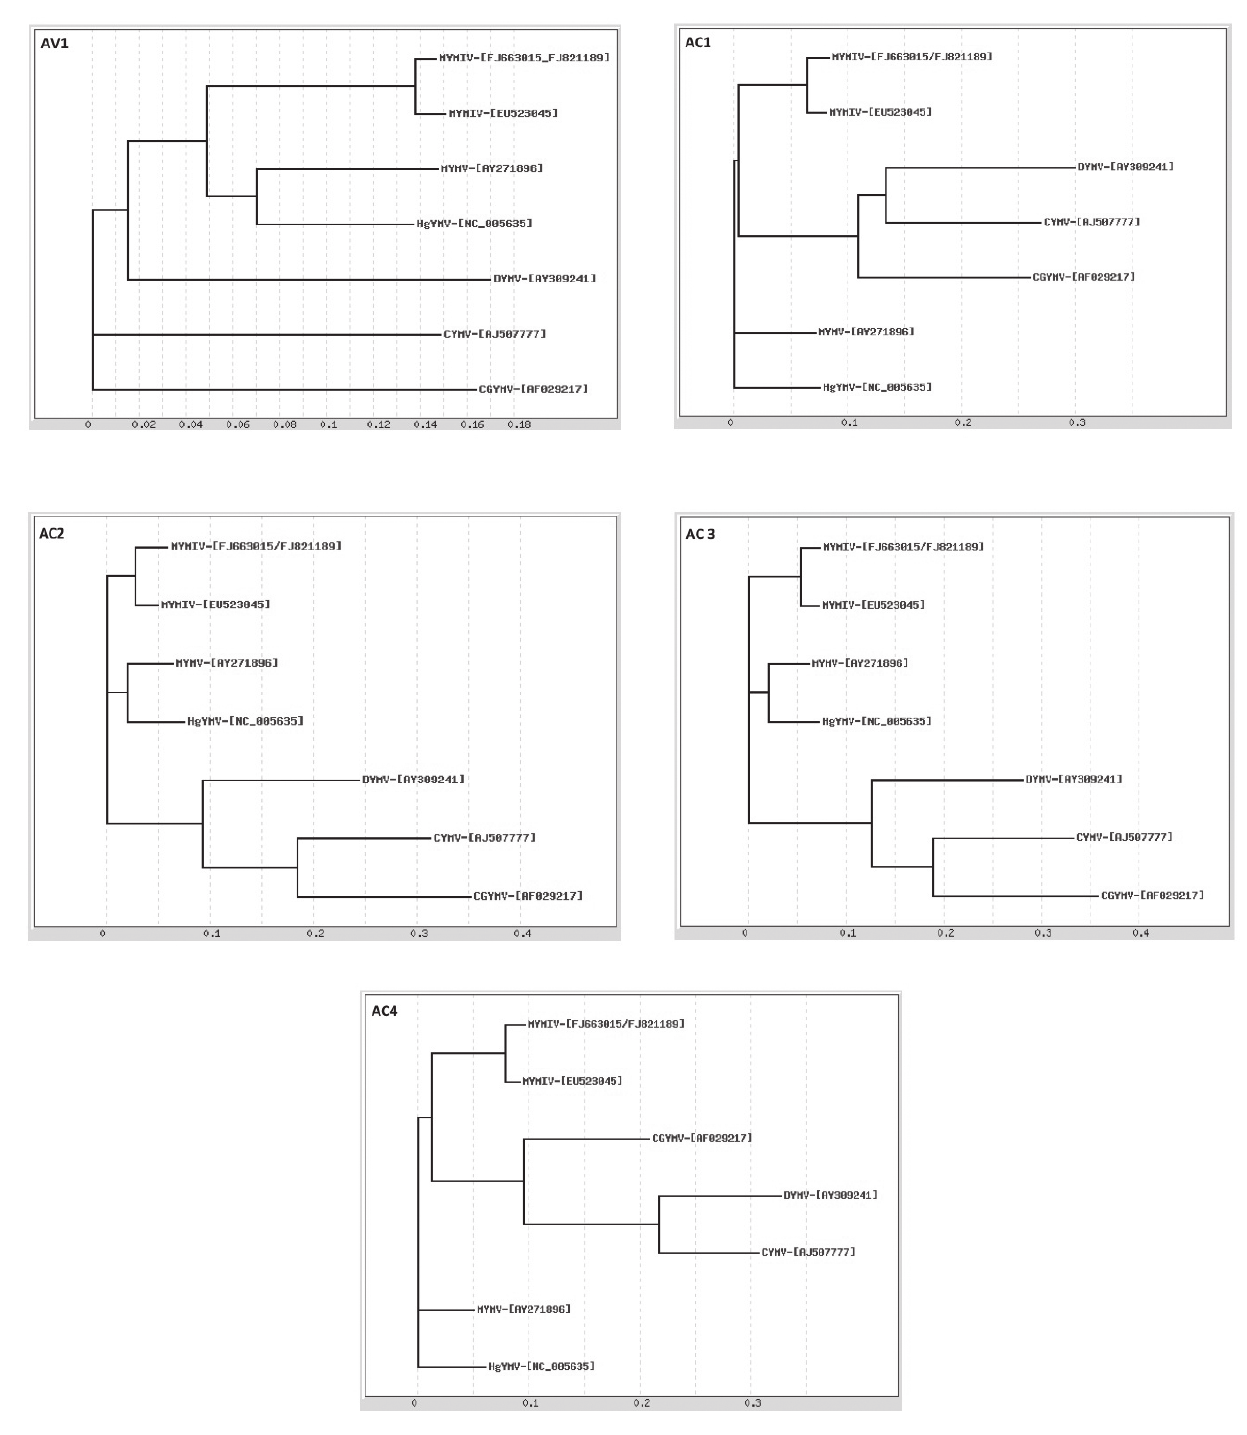
Figure 2. Cluster phylogram illustrating the phylogenetic relationship based on the multiple alignments of nucleotide sequences of genes AV1, AC1, AC2, AC3 and AC4 of the MYMIV isolate under study with the corresponding genes of some known